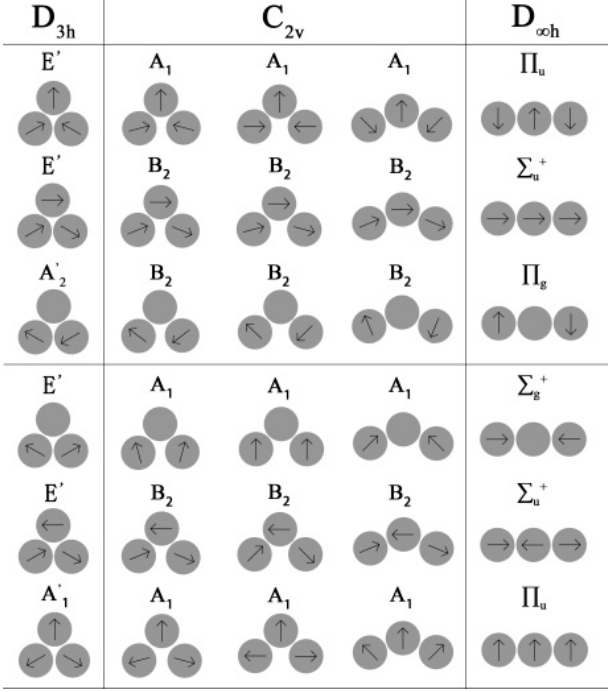
Figure 3. Dipole distributions of graphene plasmonic trimers: equilateral triangle ( D 3h symmetry) modes (left column), isosceles triangle ( C 2v symmetry) modes (center columns), and linear chain ( D ∞ h symmetry) modes (right column).